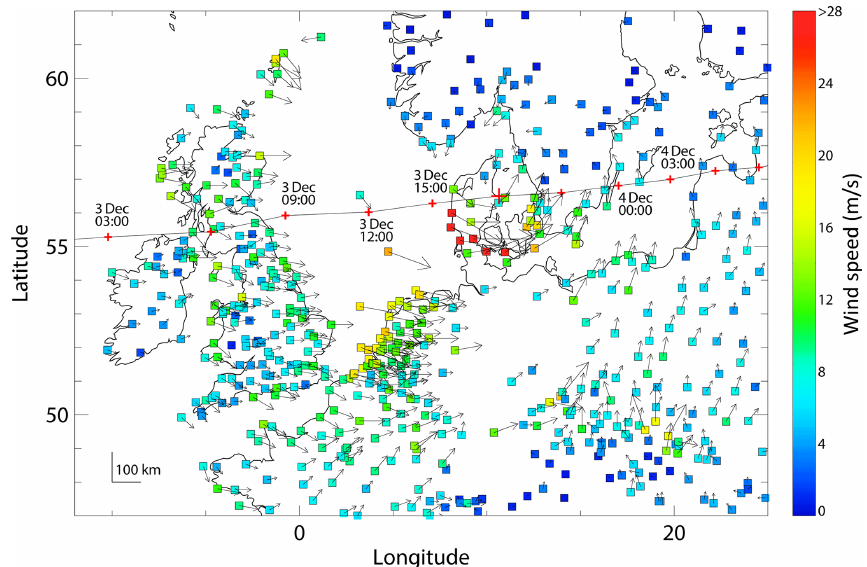
Figure 1. Wind speed and direction at 18:00GMT 3 December 1999 from selected stations of the USAF data set. The trajectory of the low pressure centre is indicated by the black line with red crosses at 3h intervals (Roberts et al., 2014; XWS, 2020). The location of the pressure centre at the time of wind field is shown by a larger